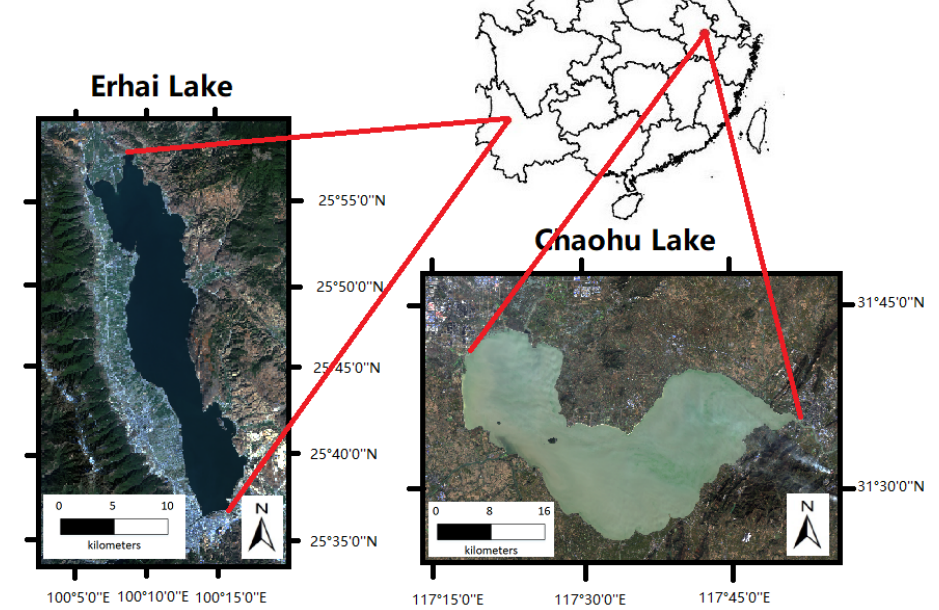
Figure 1. Spatial locations of study